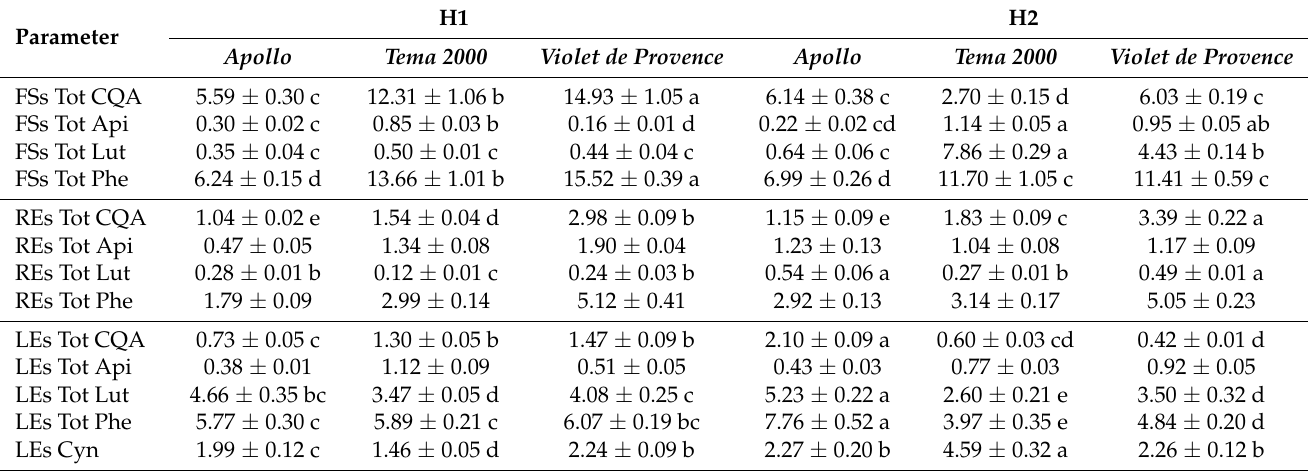
Table 4. Content (g kg − 1 of D.M.) of total caffeoylquinic acid (Tot CQA), total apigenin (Tot Api), total luteolin (Tot Lut), total measured polyphenol (Tot Phe), and cynaropicrin (Cyn) in the floral stems (FSs), receptacles (REs) and leaves (LEs) as affected by the ‘harvest time × genotype’ interaction. Different letters within the same row show significant differences among means ± s.d. (LSD test, p <